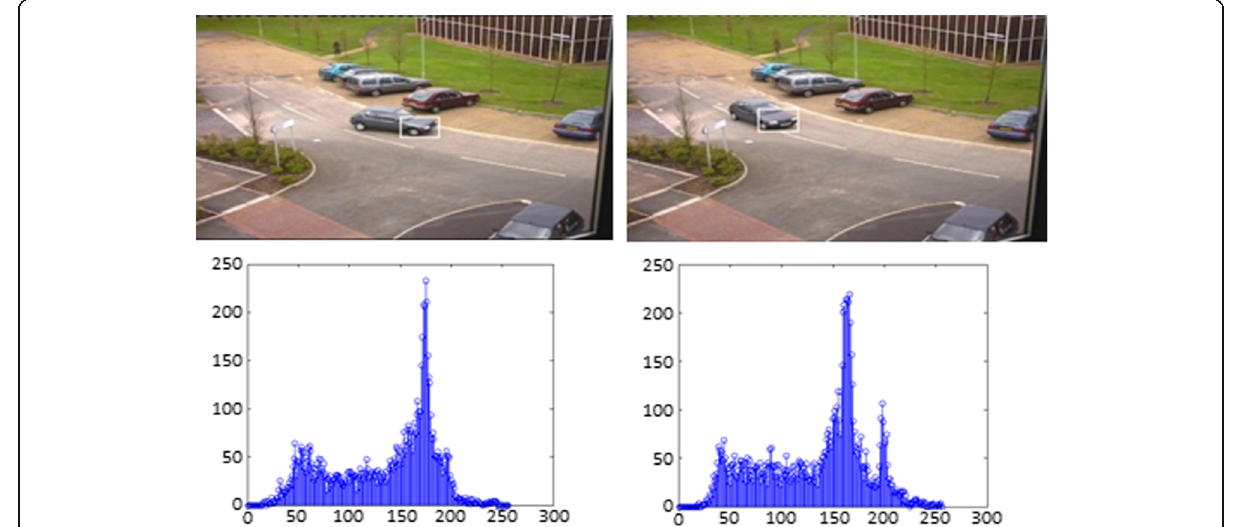
Fig. 4 Histogram of selected area of an object in two different